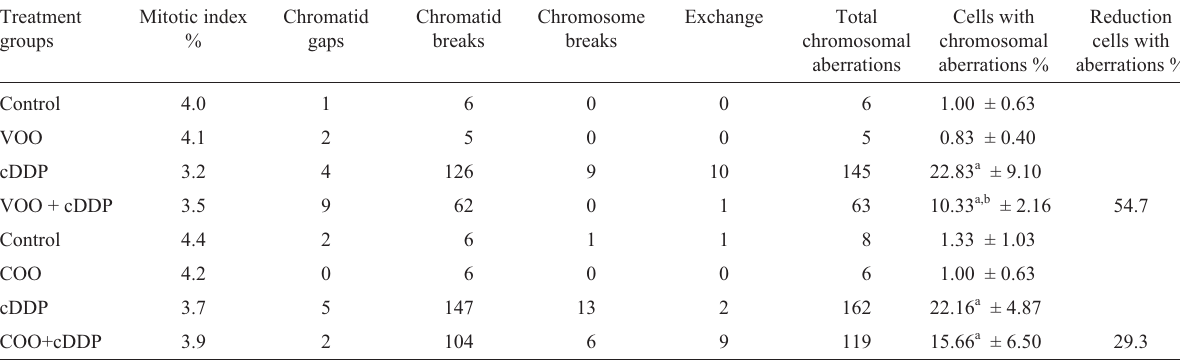
Table2 -Mitoticindex,anddistributionofdifferenttypesofchromosomeaberrations,inbonemarrowcellsofWistarratspretreatedwithvirginoliveoil (VOO) or corn oil (COO), Cisplatin (cDDP) and respective controls. Treatment